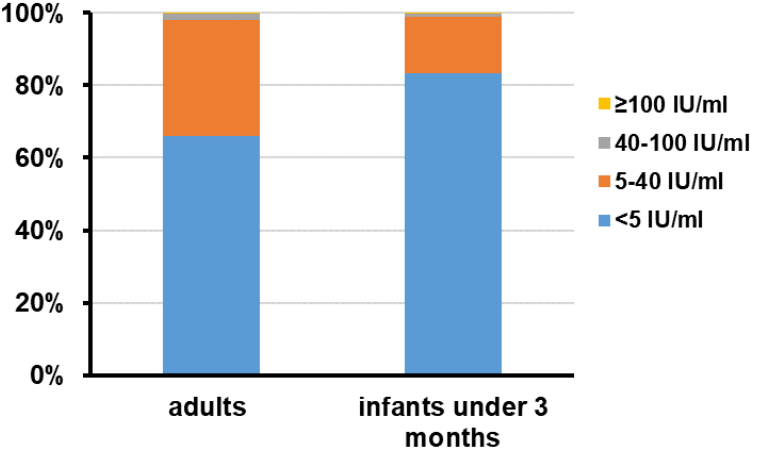
Figure 2. Distribution of serum PT IgG antibodies concentrations in adults at childbearing age and infants under 3 months old. The number of serum specimens with PT IgG antibodies concentrations ≥ 100 IU/mL, 40~100 IU/mL, 5~40 IU/mL, and <5 IU/mL in each group was calculated and the data are shown as percentage.